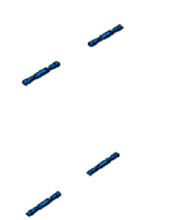
Figure 15. Connector model (side).